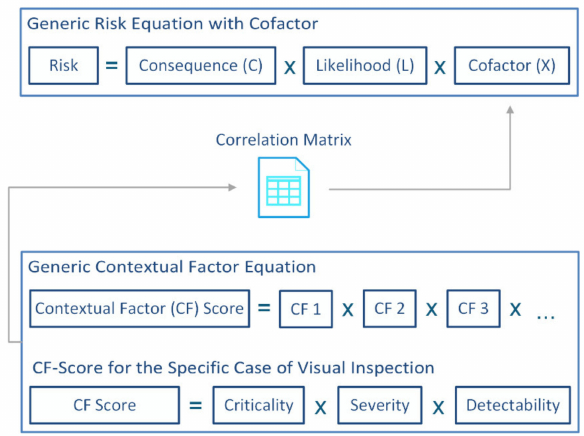
Figure 4. Calculation methodology for the risk